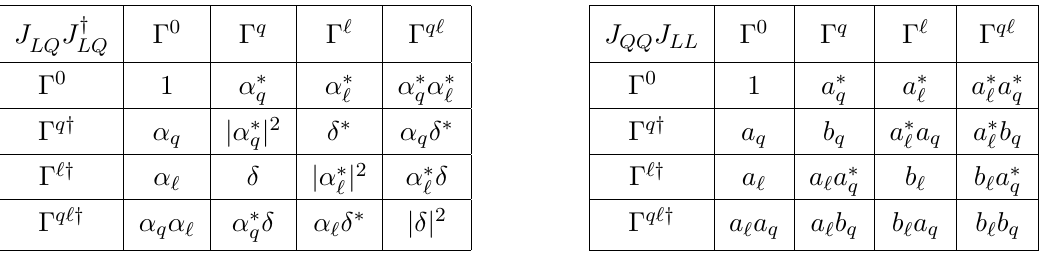
Table 2 . Tensor structures in the LQ and QQ (cid:2) LL